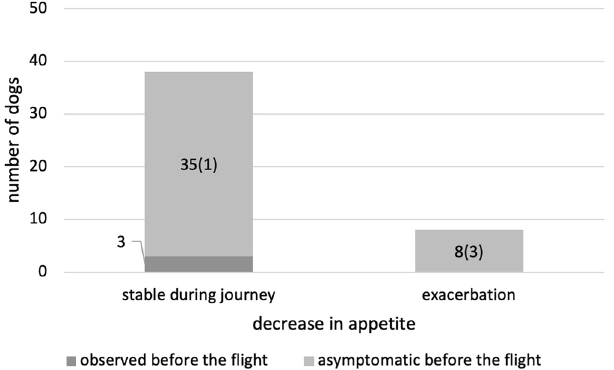
Figure 2. Decrease in appetite during the journey. The majority of dogs showed no changes in appetite compared to the status before the flight. Numbers in parentheses represent the number of dogs diagnosed with cardiac events shortly after arrival.